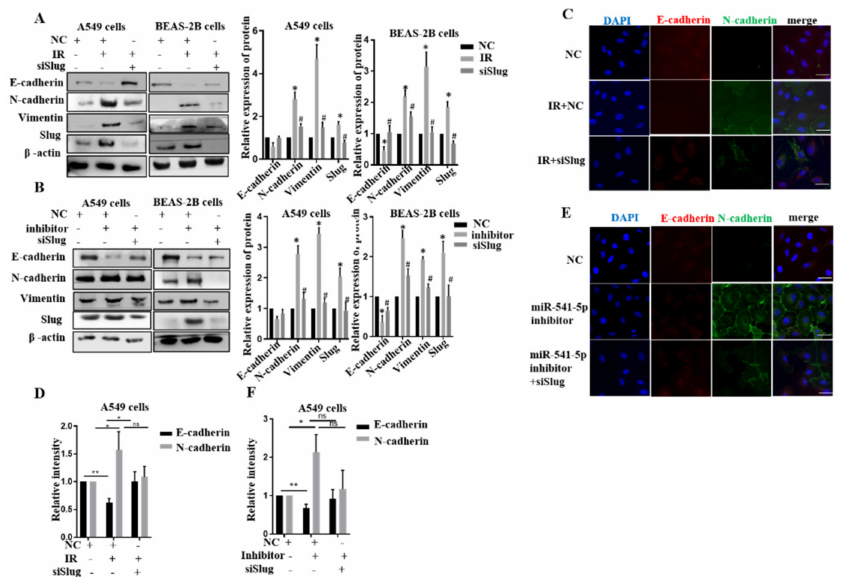
Figure 4. The siSlug inhibited the EMT induced by IR combined with the knockdown of miR–541–5p. ( A ) Transfection of siSlug (100 nM) after irradiation of A549 and BEAS-2B cells using 6 Gy and detection of EMT-related protein expression after 48 h. The histogram shows the gray value analysis. ( B ) A549 and Beas 2B cells cotransfected with miR–541–5p inhibitor and siSlug. Left: the expression of the EMT–related proteins was examined 48 h after switching to the normal medium; Right: the quantitative analysis of the protein changes using ImageJ. ( C ) Immunofluorescence analysis examined the expression of the EMT–related proteins E-cadherin and N–cadherin through the transfection of siSlug after 6 Gy irradiation. Scale bar, 20 µ m ( D ) The bar graph was generated by quantitatively analyzing the expression area and the relative fluorescence using ImageJ. * p < 0.05, ** p < 0.01 ( E ) Co–transfection of miR–541–5p and siSlug in A549 cells and immunofluorescence detection to determine the expressions of E–cadherin and N–cadherin in the cells. Scale bar, 20 µ m ( F ) The bar graph presents the quantified immunofluorescence results obtained using ImageJ. Data represents the mean ± SEM ( n = 3), * p < 0.05 versus control of the same group; # p < 0.05 versus IR or inhibitor of the same group. ns: no